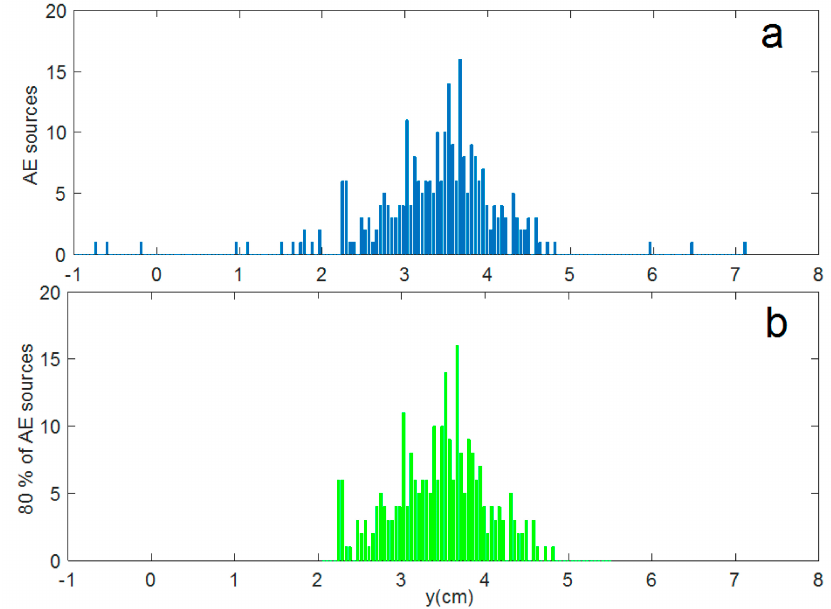
Figure 14. Histogram of the AE events detected in the aluminum plate before ( a ) and after ( b ) the application the 80% criterion. application the 80%